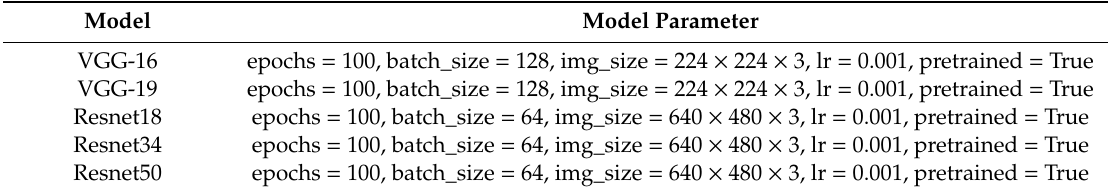
Table 9. Experimental results for di ff erent classification